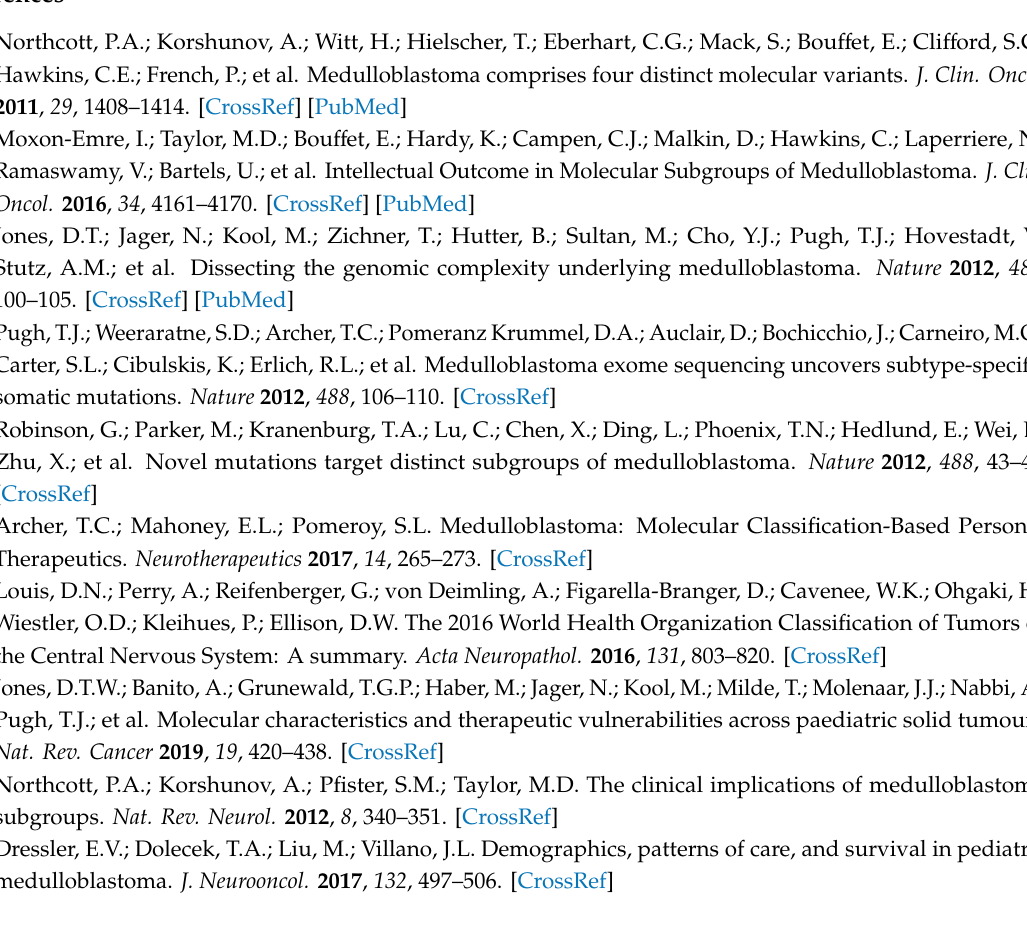
Figure S1: STAT3 expression is not due to infiltrating immune cells in Stat3 -deficient mice, Figure S2: Cre-deletion e ff ectively removes Stat3 in tumor cells in males and females, Figure S3: Stat3 Deletion does not alter proliferation or apoptosis in tumor cells, Figure S4: Stat3 deletion increases glial but not neuronal marker expression in tumor